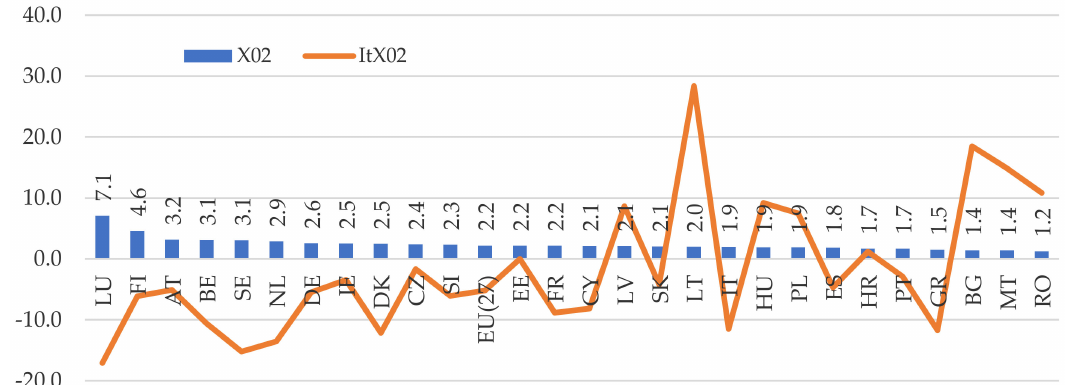
Figure 2. A ranking of EU (27) countries according to their final energy consumption in tonnes of oil equivalent per inhabitant (X 02 ) in 2019 and index I tX02 for 2019 (2010 = 100); Source: own work based on